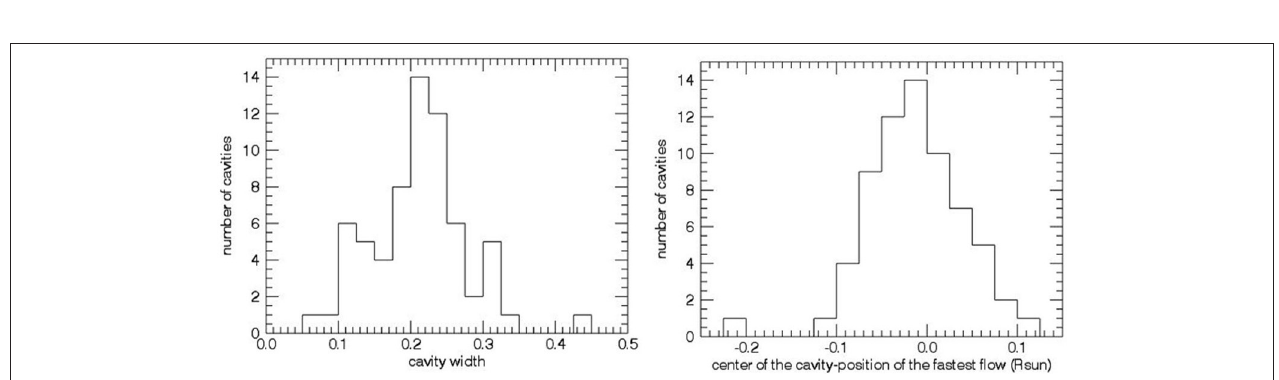
FIGURE 5 | Left: Histogram of cavity widths (R ⊙ ). Right: Position of the strongest flow relative to center of the cavity.